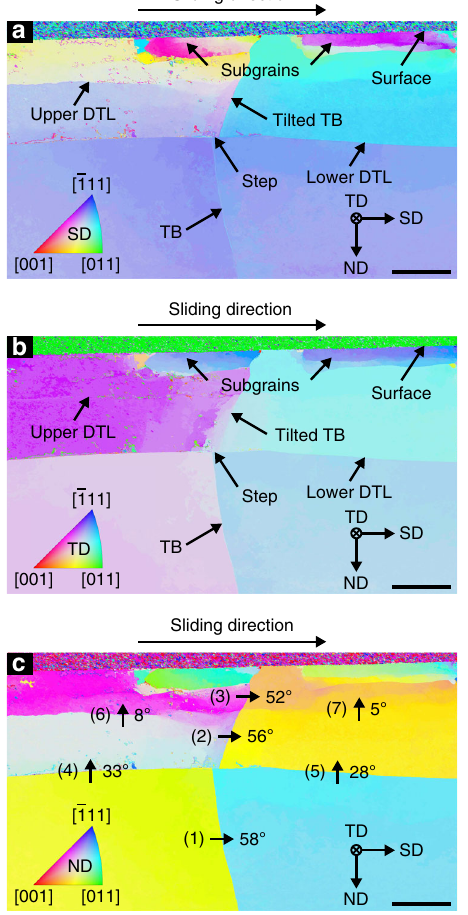
Fig. 2 Crystallographic orientation data (ACOM) of tribologically deformed microstructure after a single sliding pass in the vicinity of the TB. a Crystallographic orientation data plotted using the depicted inverse pole fi gure (IPF) color key with respect to SD. Orientation changes at both DTLs as well as orientation gradients within the subsurface subgrains are visible. b Crystallographic orientation data plotted with TD color coding. The absence of a distinct orientation (i.e. color) change at the upper DTL is of special note. c Crystallographic orientation data plotted with ND color coding. Arrows 1 – 7 denote the magnitude of the misorientation angle between the two points at the start and end of each arrow. Each given misorientation angle corresponds to the speci fi c misorientation (of all crystallographically equivalent misorientations) possessing the smallest misorientation angle for the two orientations considered. A misorientation decrease at the TB from bulk to subsurface area (arrows 1 – 3) is apparent. The lower DTL (arrows 4 and 5) accommodates a smaller misorientation than the upper DTL (arrows 6 and 7). At both DTLs, the misorientation is smaller at the segment right of the TB (arrows 5 and 7) as compared to the segment left of the TB (arrows 4 and 6). The surface normal orientations (i.e. inverse of ND) left and right of the TB in the original state below the lower DTL (start and end of arrow 1) are approximately ( − 4, 7, 0) and (5, − 4, − 2) in crystal coordinates (Miller indices). After loading this changed to approximately ( − 12, 4, 5) and (4, − 12, 1), measured above the upper DTL (start and end of arrow 3). All scale bars correspond to 250